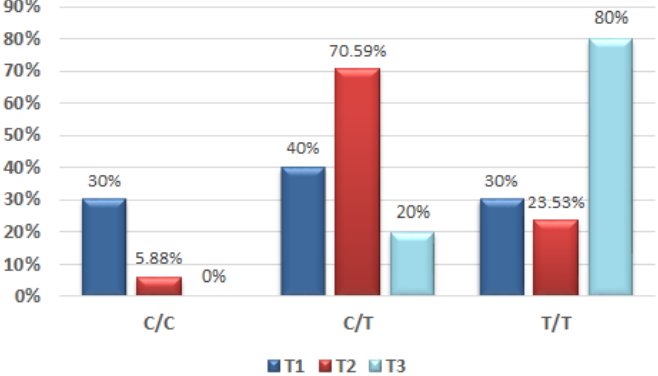
Figure 3. Tissue samples’ genetic variants in correlation with clinical staging.